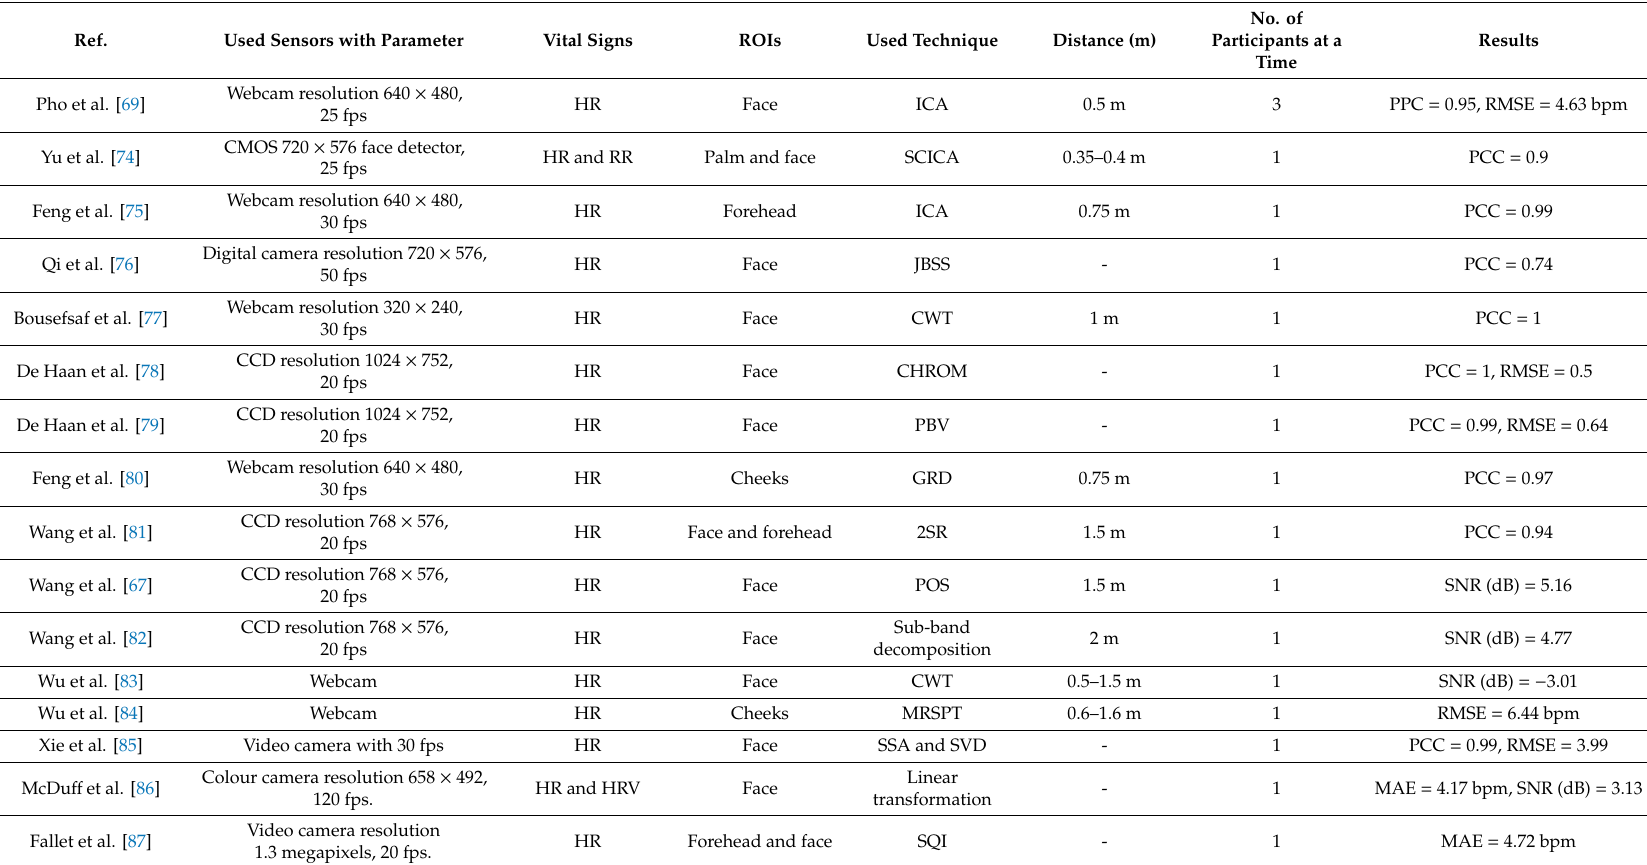
Table 2. iPPG based methods concern about motion